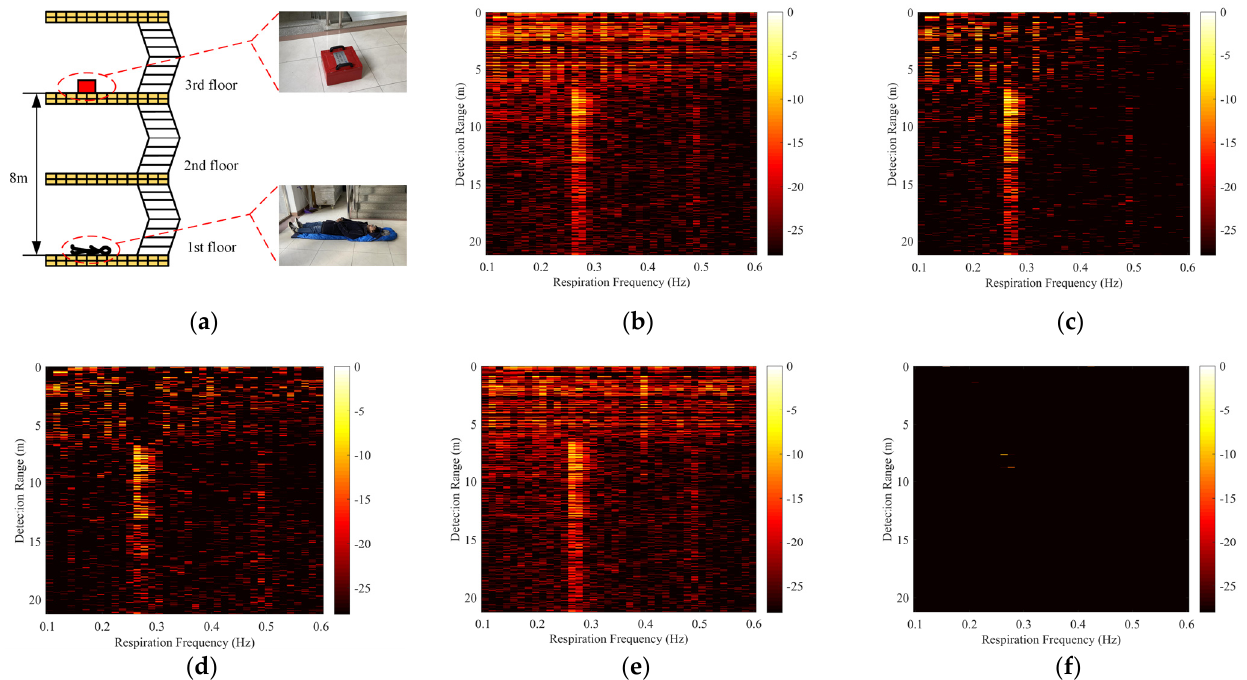
Figure 13. Realistic through-two-floors detection scenario and results. ( a ) The realistic through-two-floors detection scenario, ( b ) the direct FFT result, ( c ) the result processed by MS, ( d ) the result processed by SVD, ( e ) the result processed by the method in [36], and ( f ) the result processed by our method, where λ = 0.3.